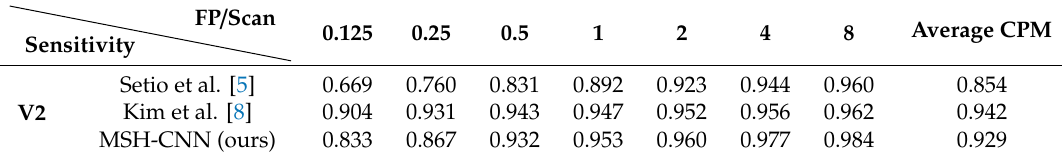
Table 4. CPM scores of di ff erent methods on V2 dataset of